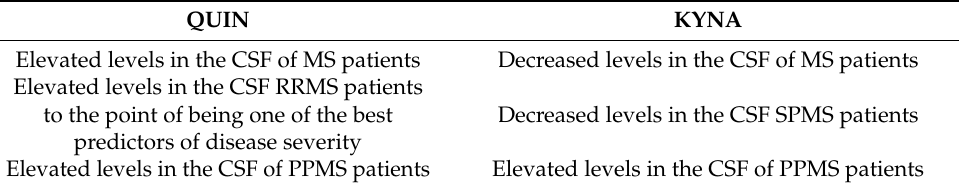
Table 3. Kynurenine pathway metabolites and enzymes—results of in vivo studies. QUIN KYNA Elevated levels in the CSF of MS patients Decreased levels in the CSF of MS patients Elevated levels in the CSF RRMS patients to the point of being one of the best Decreased levels in the CSF SPMS patients predictors of disease severity Elevated levels in the CSF of PPMS patients Elevated levels in the CSF of PPMS